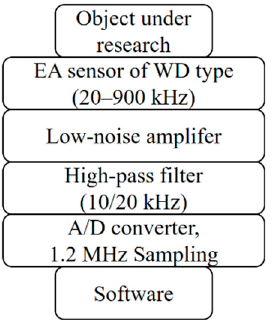
Figure 4. Block diagram of the specialist workstation for testing AE signals.